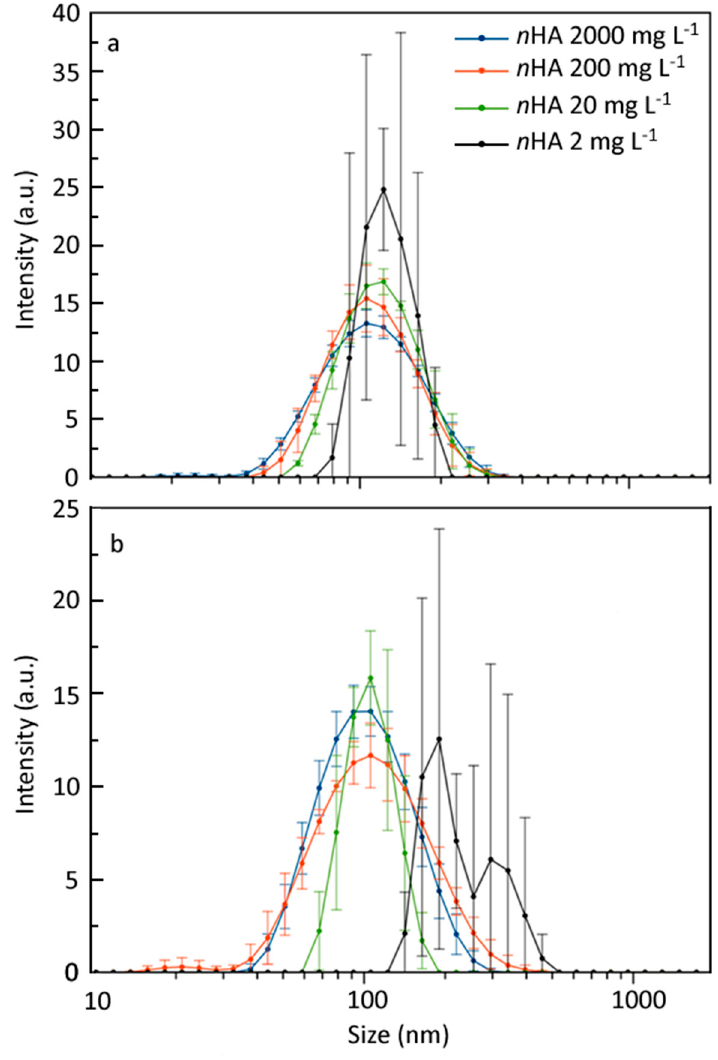
Figure 3. Size distribution measured by dynamic light scattering (DLS) on n HA suspension in Hoagland full strenght and carboxymethylcellulose (CMC) 1 % (w/v) at different concentrations after ( a ) 30 min and ( b ) 48 h. Values are expressed as the average of three replicates and error bars represent the relative standard deviation for each size point.